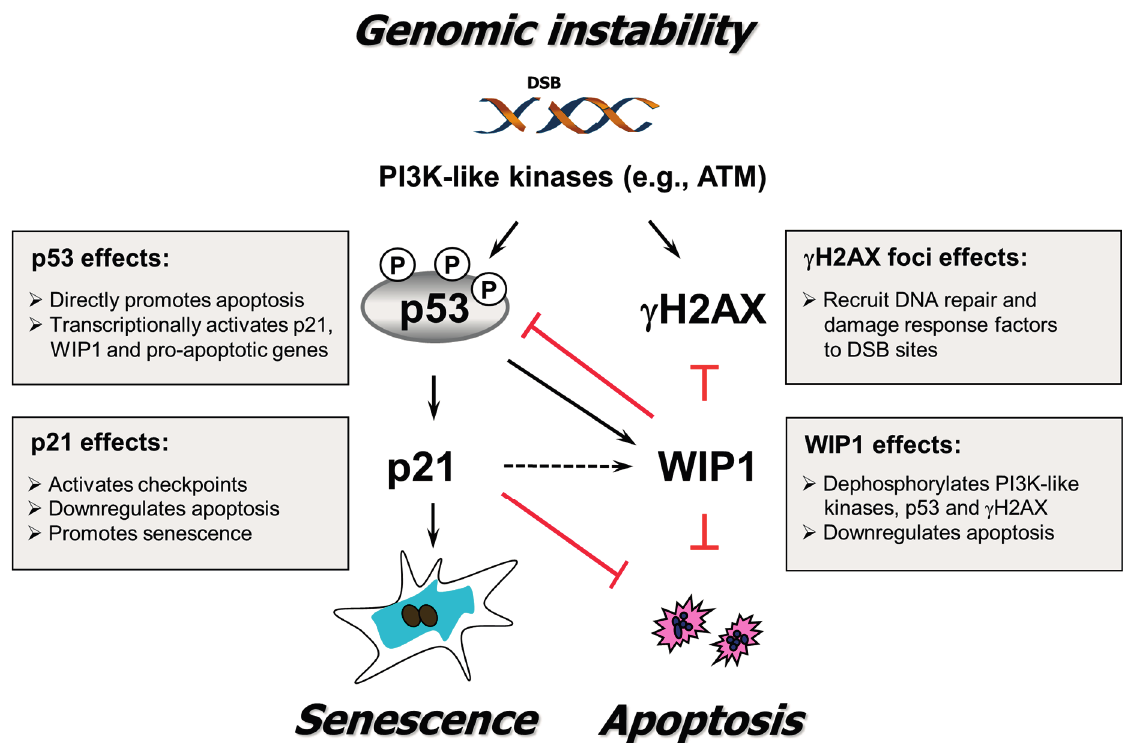
Figure 12. A schematic of the relationship between p53 signaling, γ H2AX foci, DSB repair, and biological outcomes triggered by genotoxic stress (e.g., spontaneous DSBs) supported by the current study. Solid arrows indicate stimulation and T-shaped lines indicate inhibition. The dotted arrow indicates positive regulation of WIP1 by p21 suggested by studies reported herein. Some known functions of p53, p21, WIP1, and γ H2AX are indicated (for details, consult